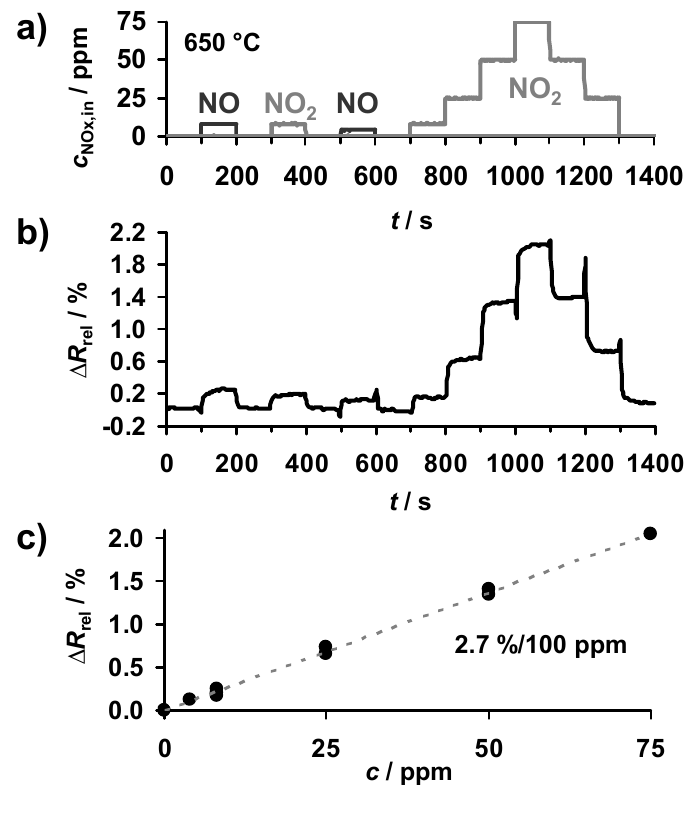
concentration detection at 650 °C: ( a ) course of NO x , ( c ) linear correlation between ∆ R rel